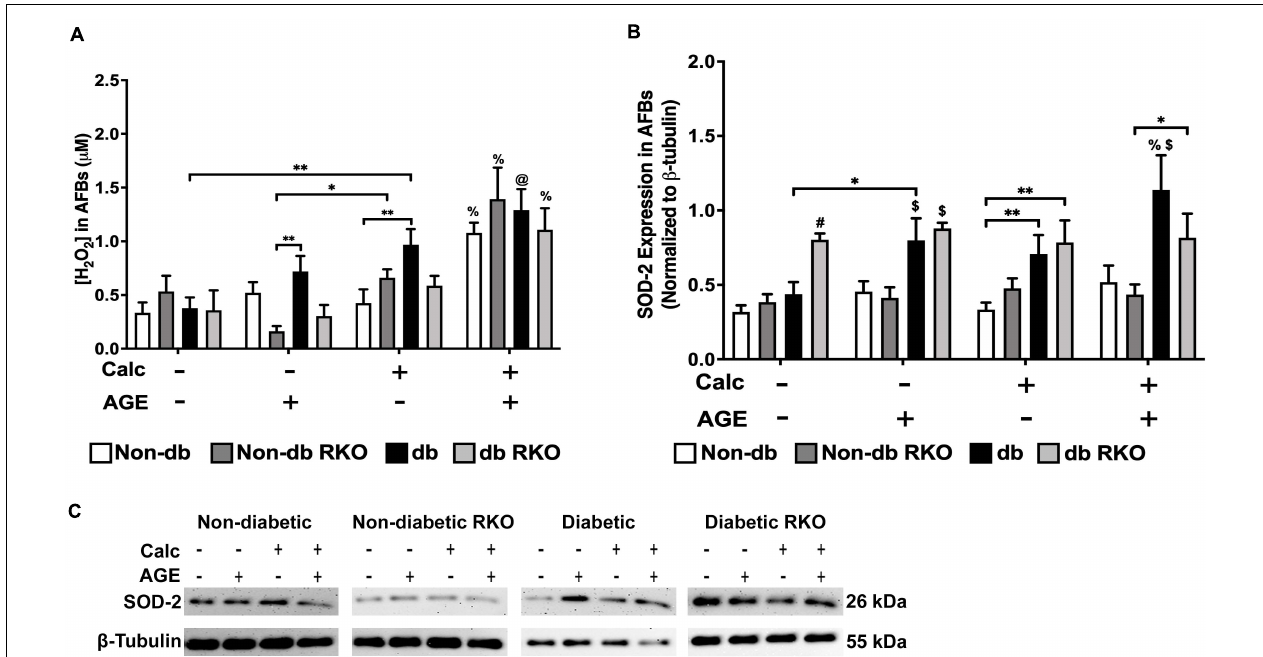
FIGURE 8 | The concentration of H 2 O 2 and SOD-2 expression was increased due to calcification and AGEs in diabetic AFBs. The concentration of H 2 O 2 was measured colorimetrically (A) . Protein expression of SOD-2 (26 kDa; B ) was quantified. Non-diabetic, non-diabetic RKO, and diabetic, and diabetic RKO primary AFBs were isolated and treated with 3 mM P i with or without AGEs (0.5 mg/mL) for 7 days. Protein levels were normalized to β -tubulin (C) and graphed as mean ± SEM with n = 6–9 of independent replicates. Statistical analysis consisted of a two-way ANOVA and a Fisher’s LSD test post hoc ( # p < 0.05 toward all other groups in treatment group, % p < 0.05 toward all other treatments within genotype, $ p < 0.05 toward non-diabetic cell types in treatment group, @ p < 0.05 toward no calcification treatments within genotype, * p < 0.05, ** p <